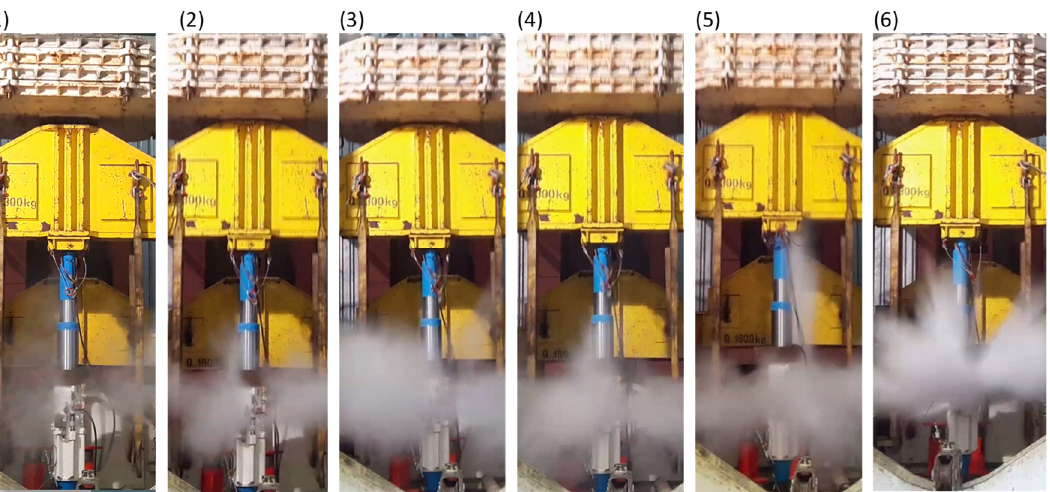
Figure 10. Opening of the safety valve during tests for different heights of impact mass drop, where: ( 1 ) drop height 20 cm, ( 2 ) drop height 30 cm, ( 3 ) drop height 40 cm, ( 4 ) drop height 50 cm, ( 5 ) drop height 60 cm, ( 6 ) drop height 70 cm.